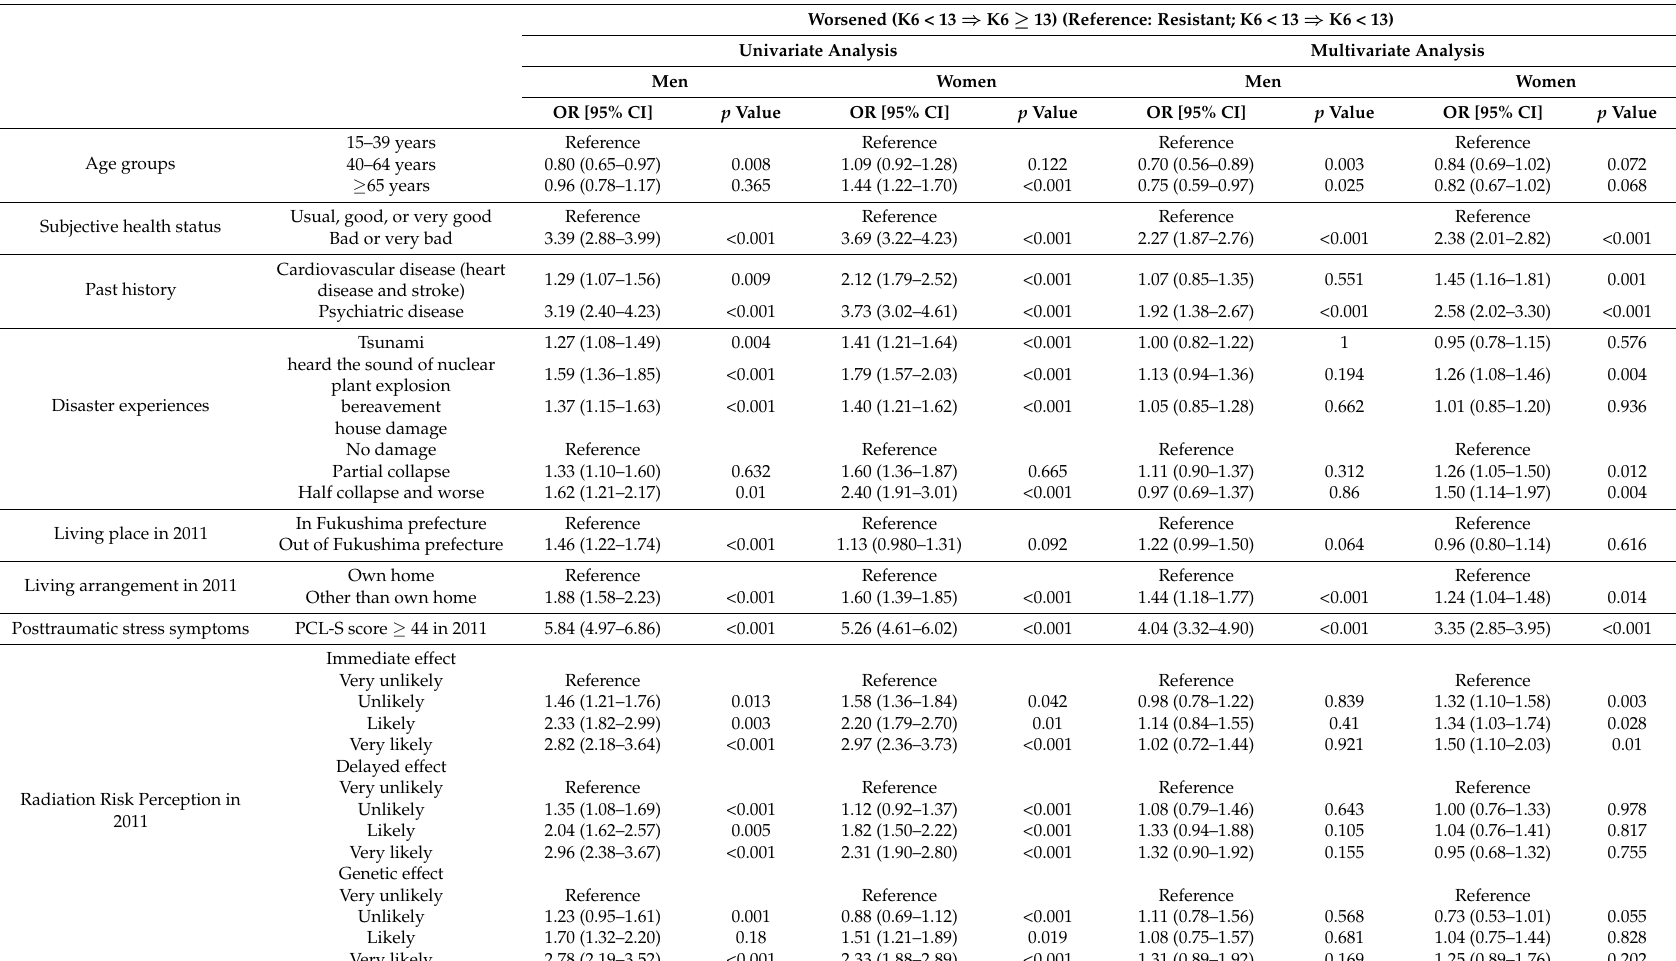
Table 2. Univariate and multivariate analysis by logistic regression comparing worsened with resistant